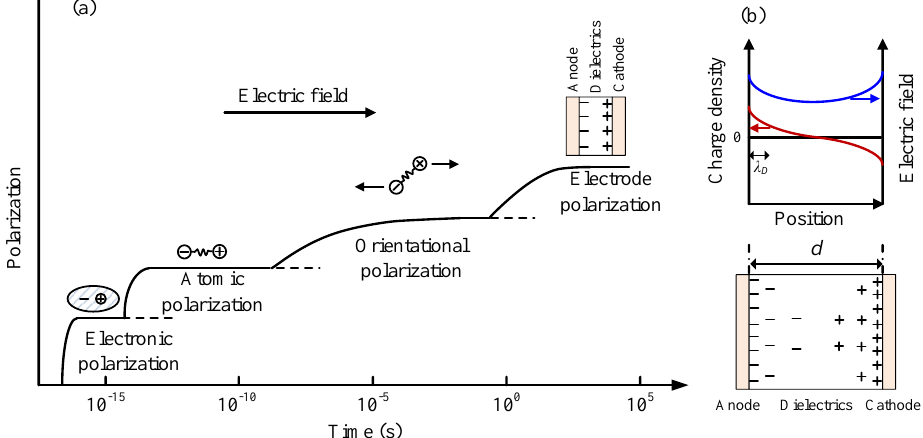
Figure 2. ( a ) Different types of polarization in a dielectric material under an electric field. With the increase in time, electronic, atomic, orientational, and electrode polarizations can be observed in the dielectric material [22]. ( b ) Distribution of hetero space charges accumulated in a dielectric material, which can form electrode polarization [24].